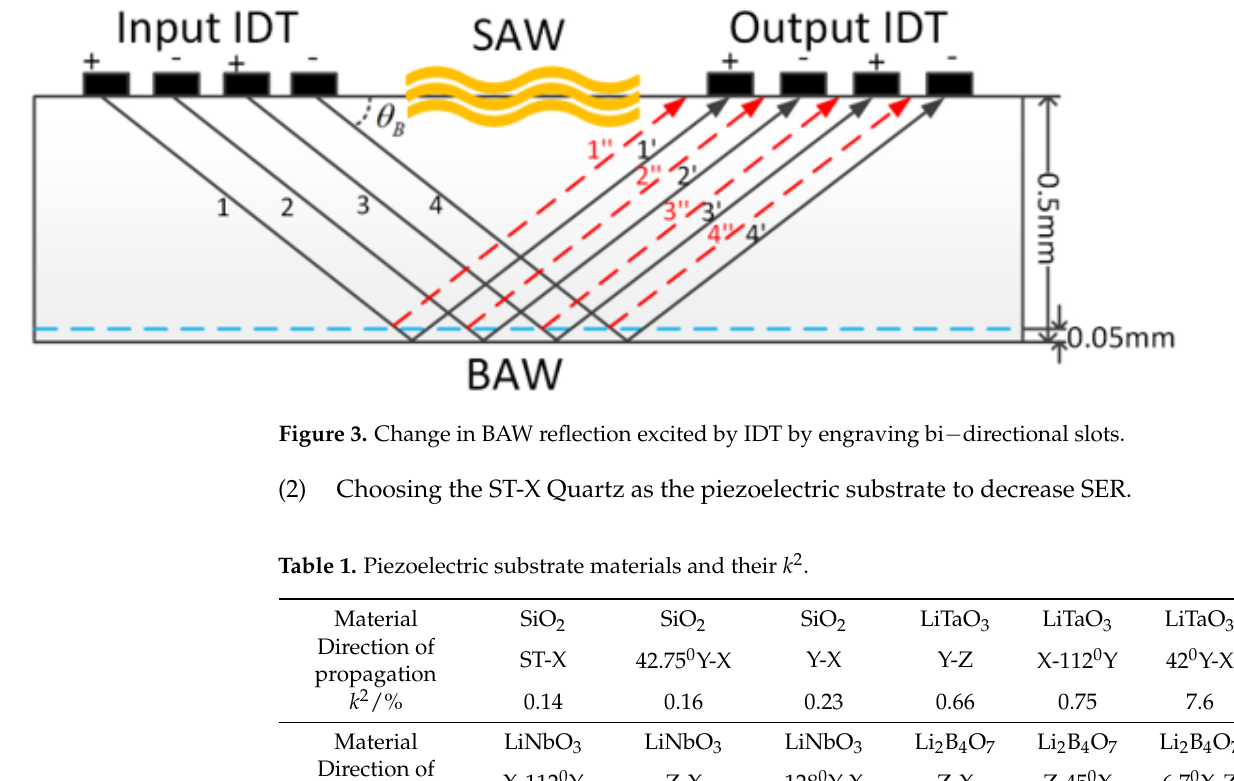
5 of 16 Figure 2. Electrode reflection of single electrodes IDTs and unbalanced-split-electrode IDTs . ( a ) Sin- gle electrodes IDTs; ( b ) Mass load (MEL) reflection of single electrodes IDTs; ( c ) Phase synthesis diagram of single electrodes IDTs; ( d ) Unbalanced-split electrodes IDTs; ( e ) Mass load (MEL) reflec- tion of unbalanced-split electrodes IDTs; ( f ) Phase synthesis diagram of unbalanced-split electrodes IDTs. Table 1. Piezoelectric substrate materials and their 𝑘 (cid:2870) . Material